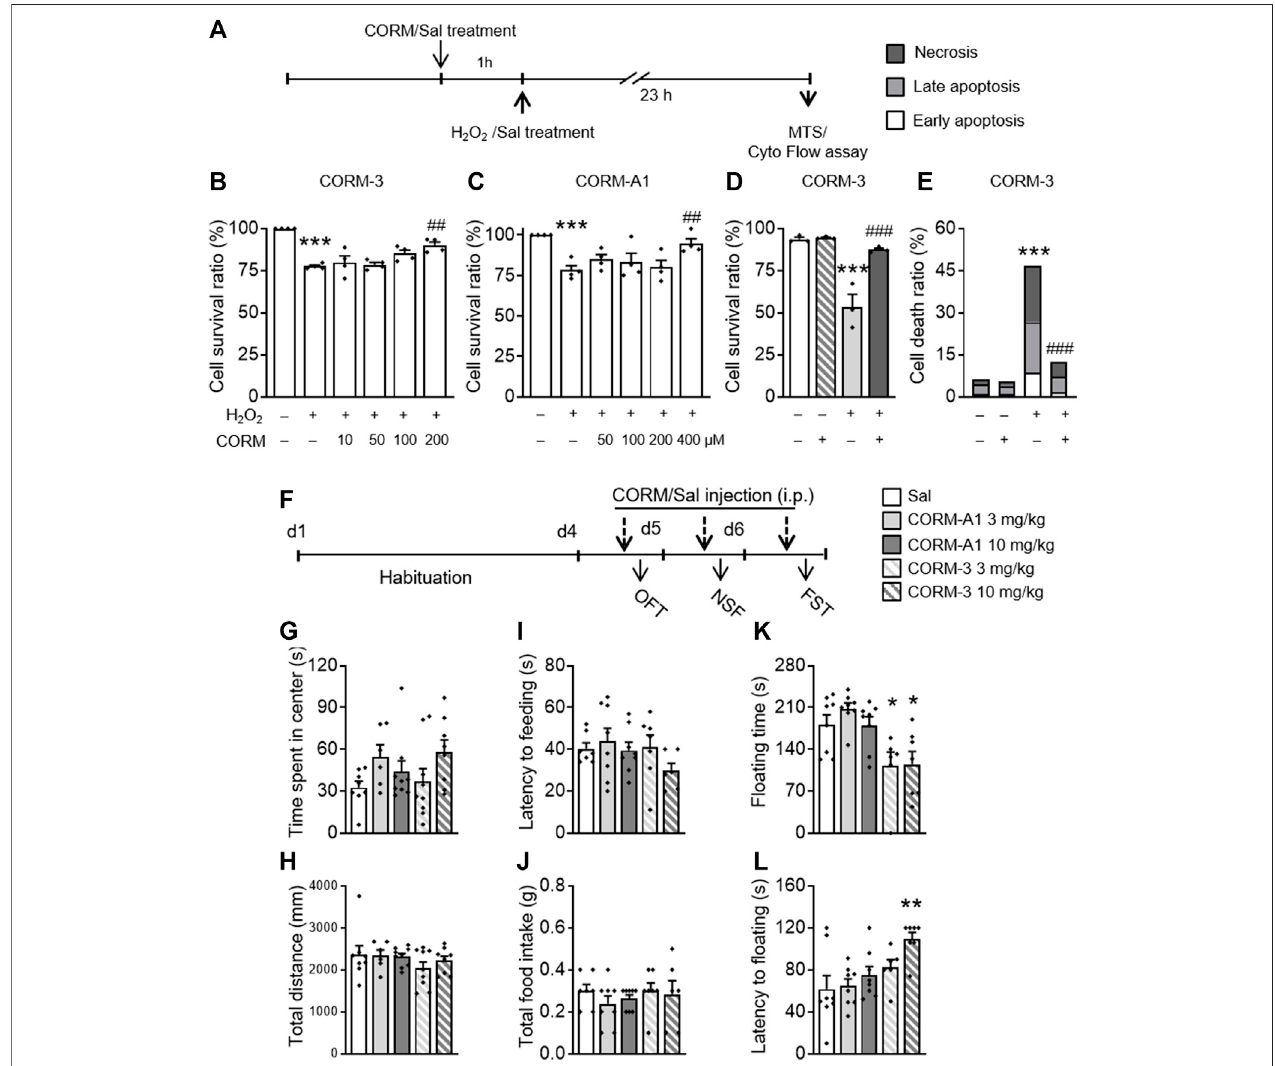
FIGURE 2 | CO-RM pretreatment exerted protective effects in vitro and in vivo . (A) CO-RM donor/saline was administered 1 h before H 2 O 2 /saline treatment; MTS or fl ow cytometry assay was conducted 24 h later. 100, 200 μ M CO-RM-3 (B) , and 400 μ M CO-RM-A1 (C) preconditioning signi fi cantly blocked H 2 O 2 -induced PC12 cell injury in the MTS assay. Protective effects of CO-RM-3 pretreatment (D) would be associated with its inhibitory role on H 2 O 2 -induced necrosis and apoptosis (E) detected by the fl ow cytometry assay. (F) CO-RM-A1 (3, 10 mg/kg, i.p.) or CO-RM-3 (3, 10 mg/kg, i.p.) was administered daily 30 min prior to behavioral testing. CO-RM-A1 and CO-RM-3 administration had no effect on time spent in the central zone (G) and total distance (H) during the OFT. CO-RM-A1 and CO-RM-3 administrationdidnotaffectthelatencytofeeding (I) andtotalintakeoffood (J) intheNSFtest.CO-RM-3(3,10 mg/kg)signi fi cantlyreduced fl oatingtime (K) intheFST. CO-RM-3 treatment at 10 mg/kg dose signi fi cantly increased the fl oating latency (L) in the FST. The data are expressed as mean ± SEM and were analyzed with separateone-wayANOVAs.*** p < 0.001ascomparedtothecontrolgroup; # p < 0.05, ## p < 0.01, ### p < 0.001ascomparedtotheH 2 O 2 -treatedgroup;* p < 0.05,** p < 0.01 as compared to the Sal group; Sal, saline. CO-RM, carbon monoxide – releasing molecule; OFT, open fi eld test; NSF, novelty-suppressed feeding; FST, forced swimming test ( n (cid:2) 4 per group for cellular analysis, n (cid:2) 6 – 9 per group for behavioral tests).